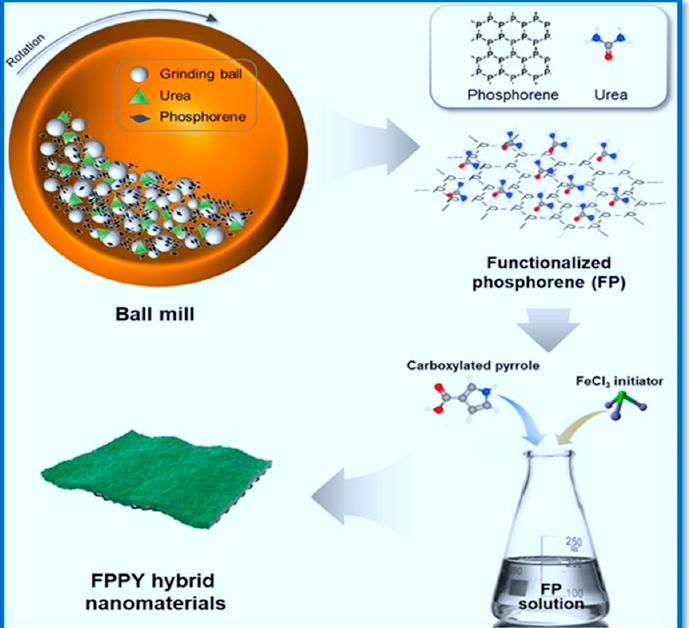
Figure 9. Schematic of the fabrication of FPPY hybrid nanomaterials via the polymerization of car- boxylated PY on to FP nanosheets using a FeCl 3 initiator. The FP was prepared via mechanical mill- ing of phosphorene with urea. Copyright 2020, Elsevier Inc. Reproduced with permission from Jour- nal of Industrial and Engineering Chemistry [119], Copyright 2020 the Korean Society of Industrial and Engineering Chemistry. Published by Elsevier B.V.